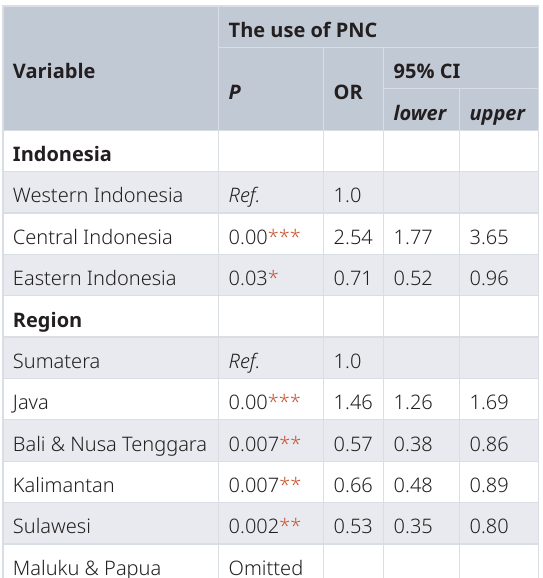
Table 4. Binary logistic regression of PNC utilisation among mothers aged 15–49 years old in Indonesia based on geographical location.